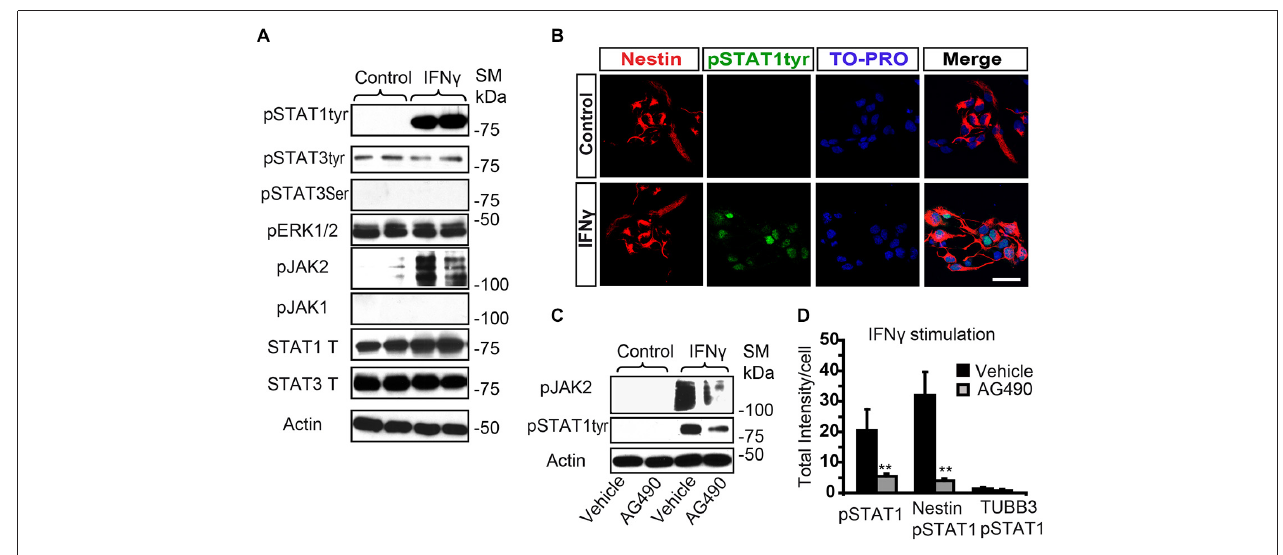
(red; n = 4), TO-PRO (blue) labeled all nuclei. (C) The presence of the AG490 STAT1 inhibitor reduced STAT1 phosphorylation ( n = 4 per time point). Actin was the loading control. (D) Histogram represents immunoreactivity signal intensity of STAT1 Tyr701 per Nestin+ cell after IFN γ stimulation in the presence or absence of AG490 inhibitor. After IFN γ stimulation, phosphorylation of STAT1S Tyr701 was increased in Nestin+ progenitors and the presence of the JAK2 phosphorylation inhibitor AG490 impeded STAT1 phosphorylation ( n = 4). Scale bar: (B) 30 µ m. Data are represented as mean ± SEM. ** p ≤